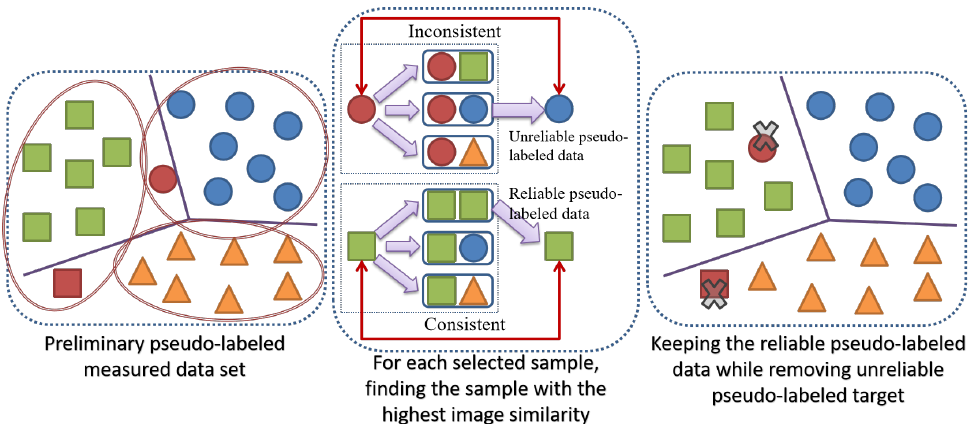
Figure 6. Illustration of pseudo-label denoising method. Different colors (except for red) are predicted categories according to the learned classification boundaries. Different shapes represent real cate- gories. The red color means mispredicted categories, while the samples in the same circle represent the relationship with relatively higher